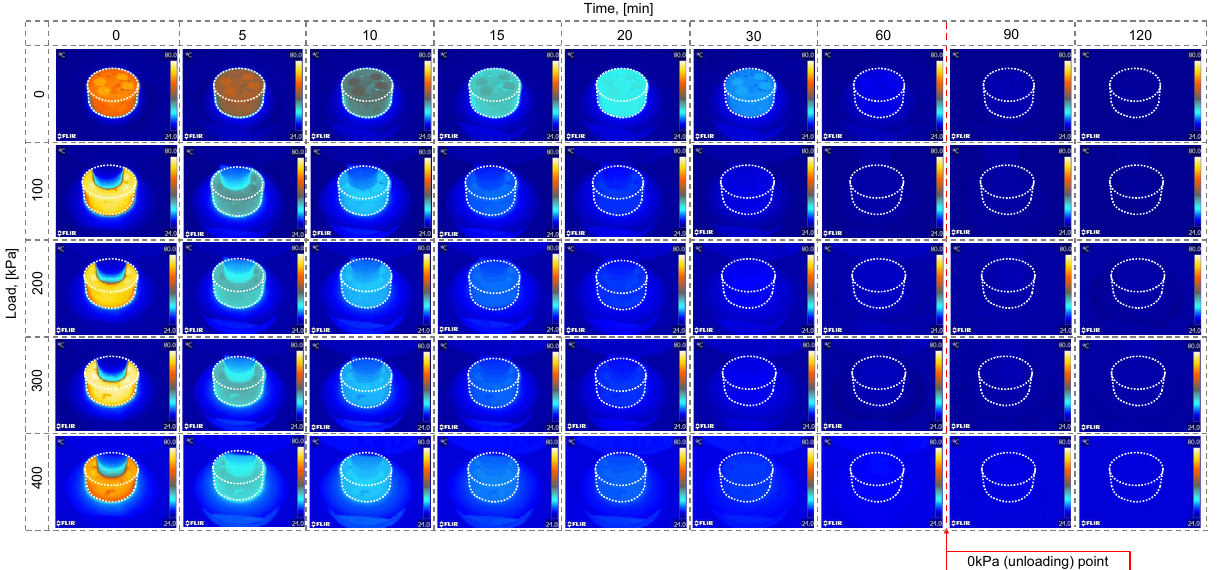
Figure 8. Thermal image measured by infrared thermography in the active method.